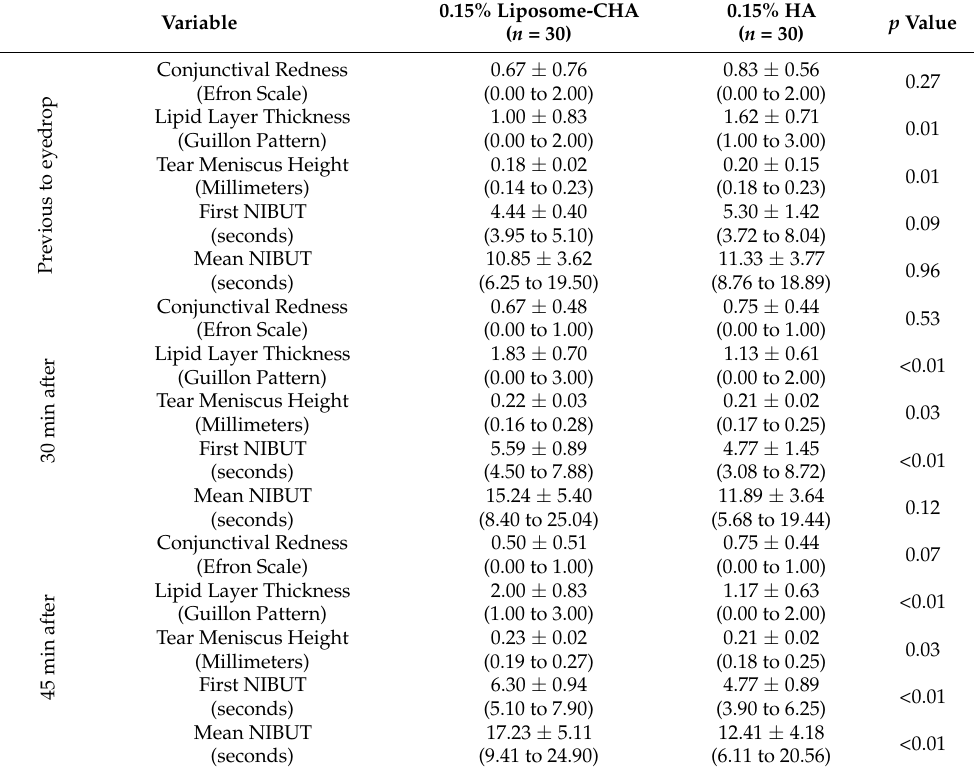
Table 2. Ocular surface analyzer comparison previous and after both eyedrop